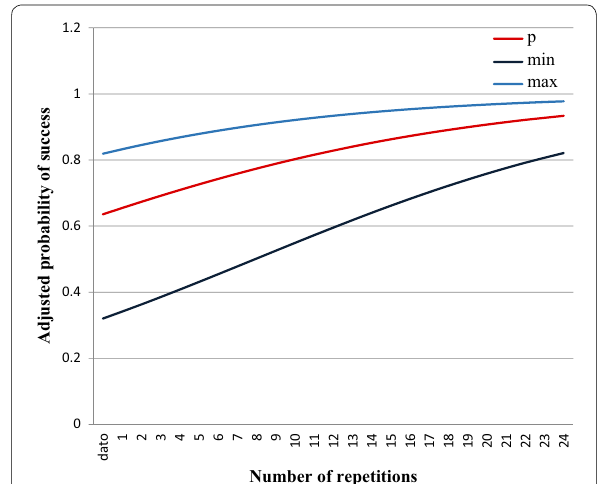
Fig. 1 Learning curve for point‑of‑care ultrasound technique for sub‑ xiphoid visualization of the IVC by novice EM Colombian residents. The y axis shows the probability of success adjusted by repetition and resident. The x axis shows the repetition number. The curve shows how the probability of success increases with number of repetitions. The red line is the average probability, while the blue lines represent minimum and maximum